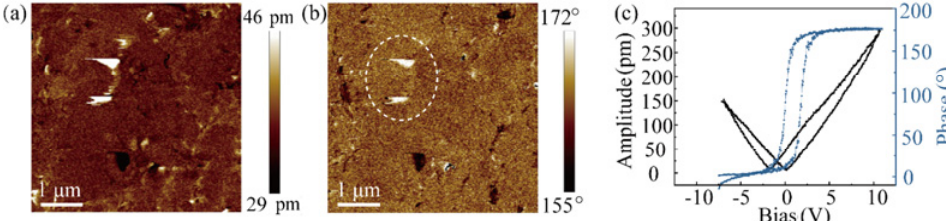
Fig. 10 Vertical PFM images of surface of the BLYDTFO ceramics: (a) PFM amplitude image, (b) PFM phase image, and (c) local SS-PFM amplitude curve and phase